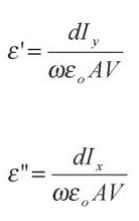
Figure 1. Real and imaginary parts of the complex permittivity for the copolymer PVDF-HFP (90/10).